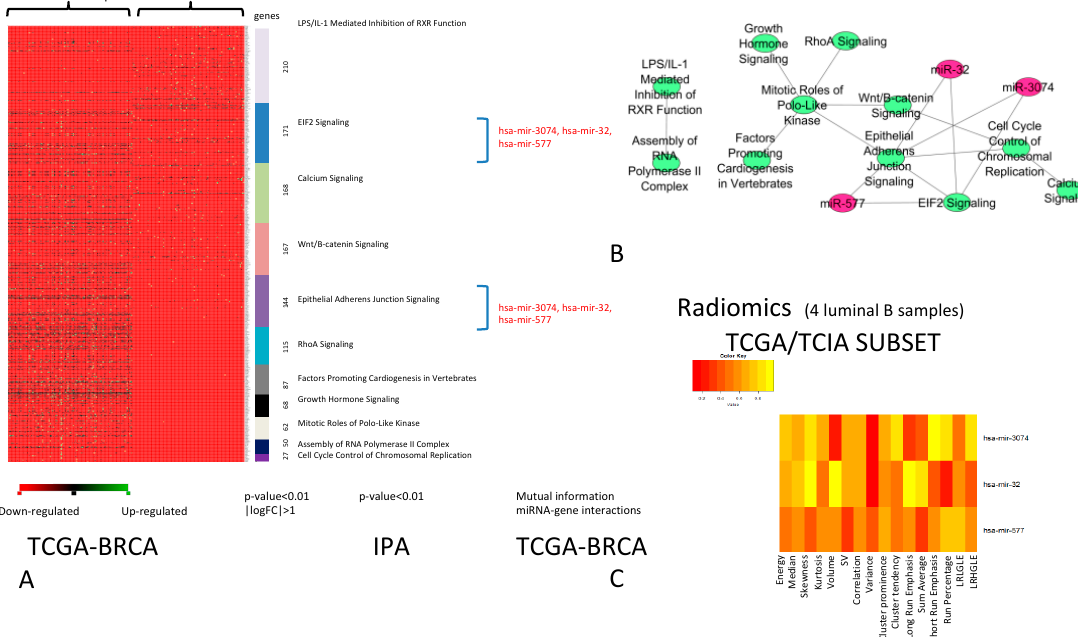
Figure 2. BC Luminal B. ( A ) Pathways able to classify Luminal B vs. normal samples ( p -value < 0.01, |logFC| > 1). For each pathway (in different colours), miRNAs (in red) able to regulate DEGs are indicated. ( B ) Relationships between pathways and miRNAs (green nodes are the pathways and purple nodes are the miRNAs). ( C ) Heatmap of the correlation between imaging features and miRNAs. The color intensity in the figure shows the corresponding p -value; yellow cells indicate greater statistical significance.